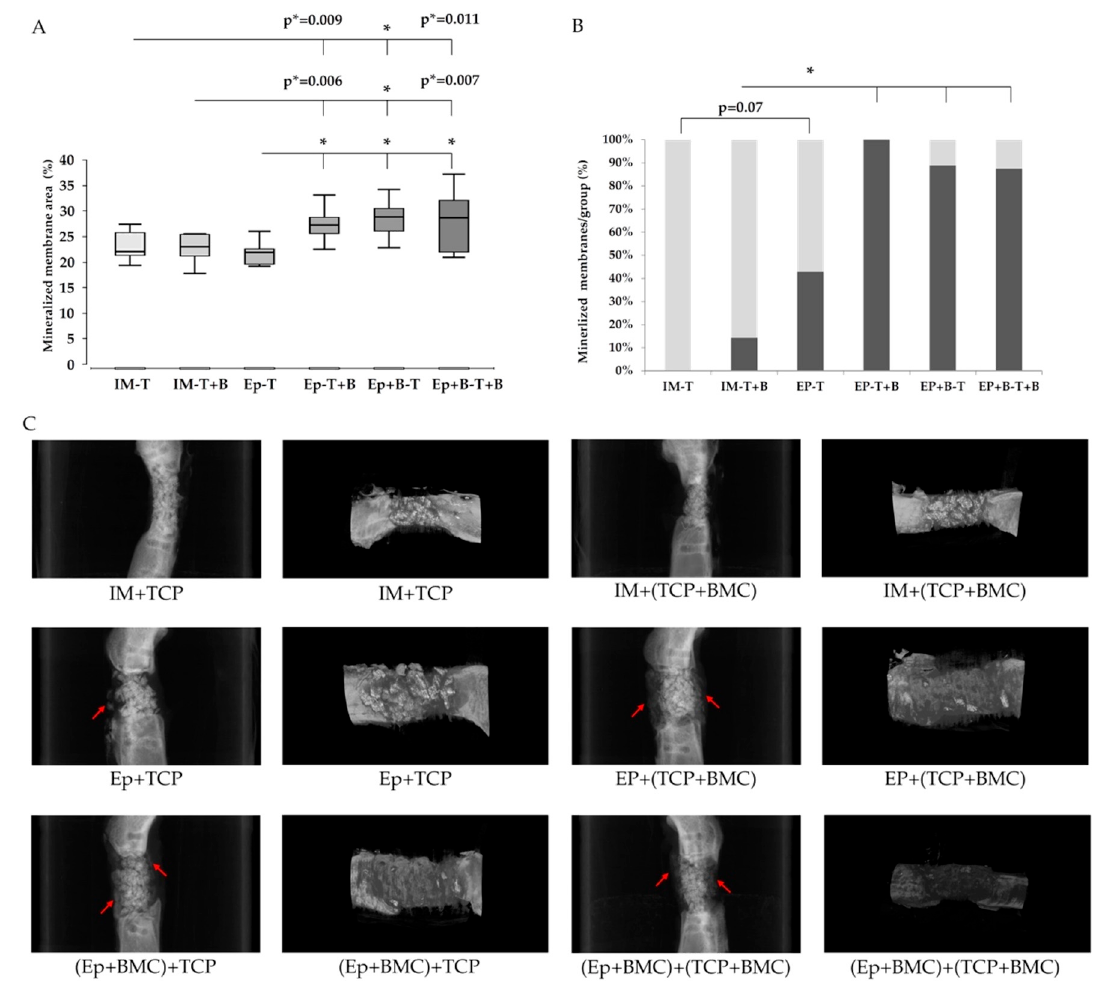
Figure 4. Confirmation of increased mineralization of the decellularized dermis in presence of BMC using µ CT analysis ( A ). The percentage of samples with mineralized defect coating in each group is presented in ( B ). Representative µ CT images are shown in ( C ). Left column: sagittal plane of the bone samples, arrows indicate mineralized dermis. Right column: surface reconstruction revealed deposition of mineralized material covering the scaffold granules in bone defects treated with decellularized dermis and BMC. * = p < 0.05. p * = uncorrected p-value, indicates a statistical trend.